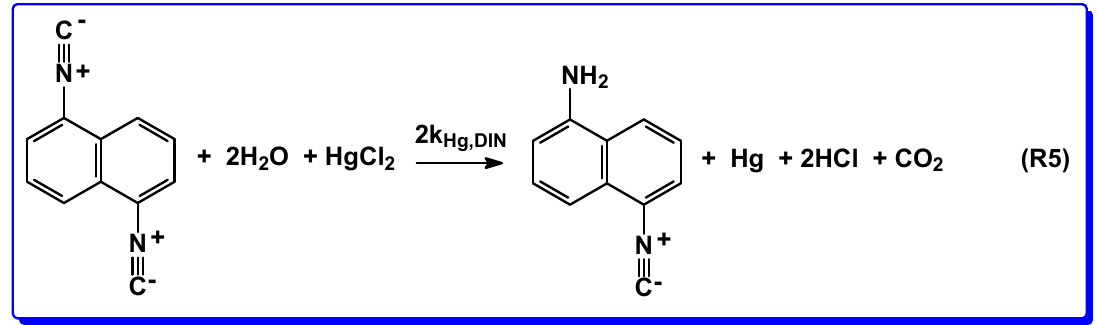
Scheme 3. Reaction of 1,5-DIN with water and HgCl 2 . Factor 2 in the rate-coefficient (k Hg,DIN ) expresses